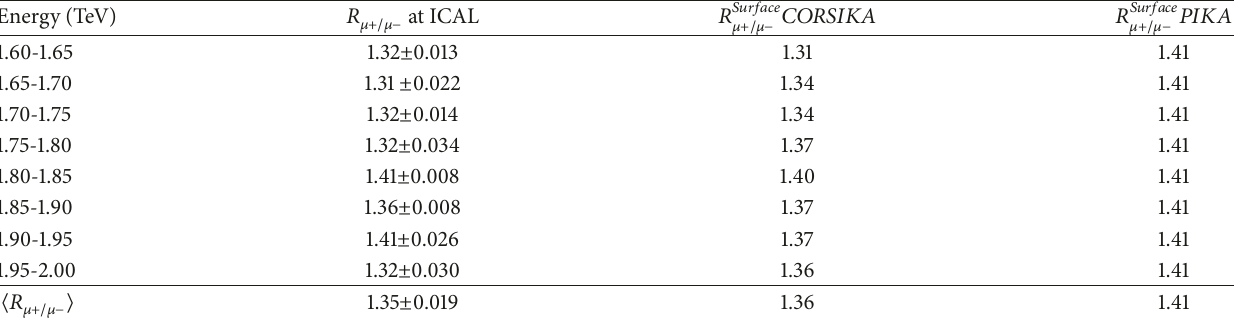
Figure 12: Muon charge ratio with statistical errors at the INO-ICAL detector as a function of surface muon energy, obtained using the CORSIKA data. Table 1: Data Table for Charge Ratio Analysis from Vertical